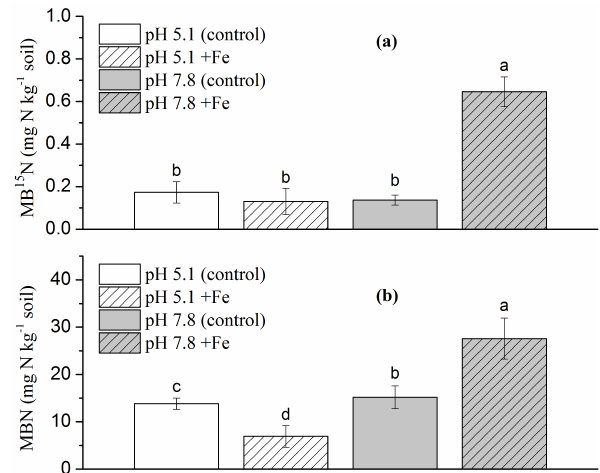
Figure 3. Effects of Fe oxide on gross mineralization rate (a) and net nitrification rate (b) during 6 days for soil samples incubated at 28 ◦ C with soil moisture at 100% WHC. Error bars represent standard deviations; n = 3. The different letters above the columns indicate a significant difference ( P <0.05).